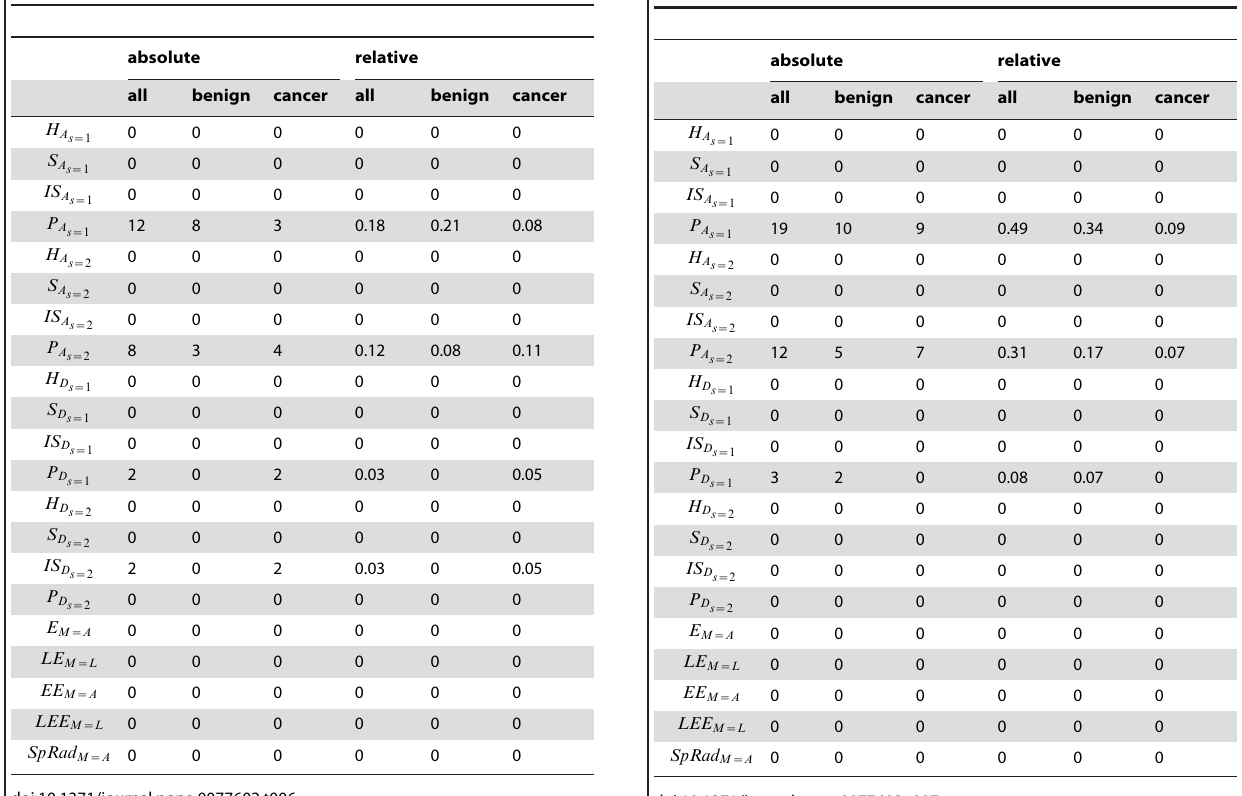
Table 6. ndV-values for the structural biomarkers (eigenvalue and entropy-based measures) for prostate cancer networks and the corresponding subgroups (benign/cancer) for [52].